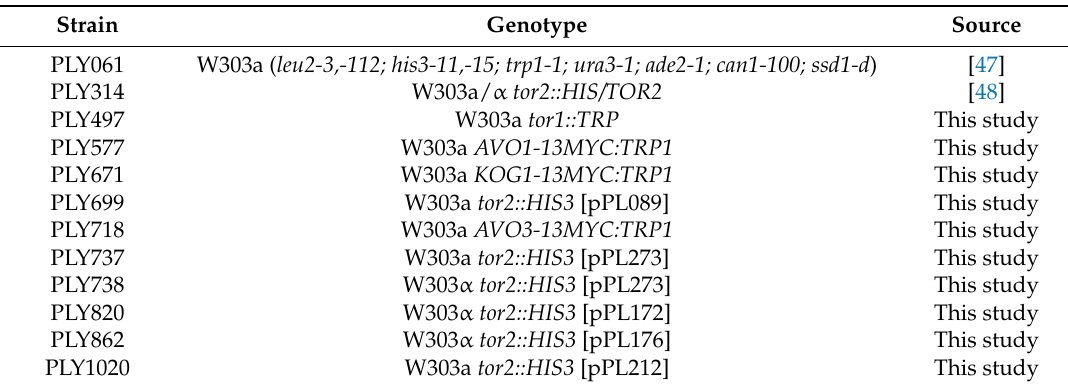
Table 3. Yeast strains used in this